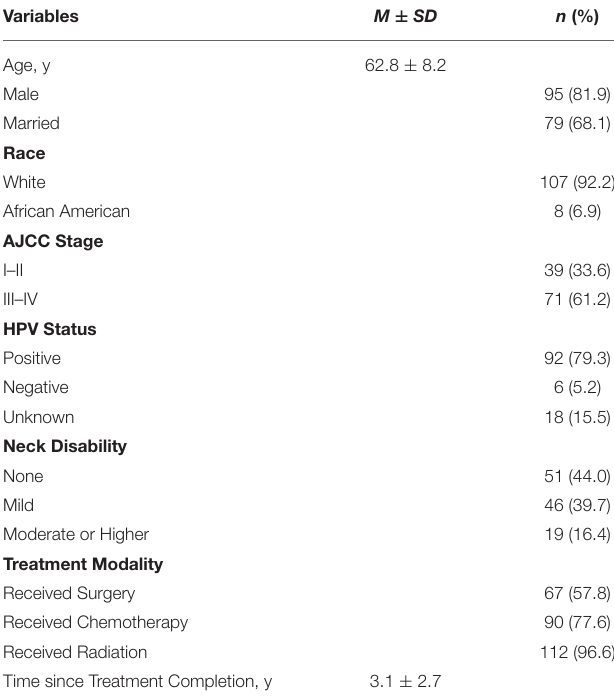
TABLE 1 | Demographic and clinical characteristics ( n = 116). TABLE 2 | Univariable regression between neck disability scores and clinical and demographic characteristics ( n =